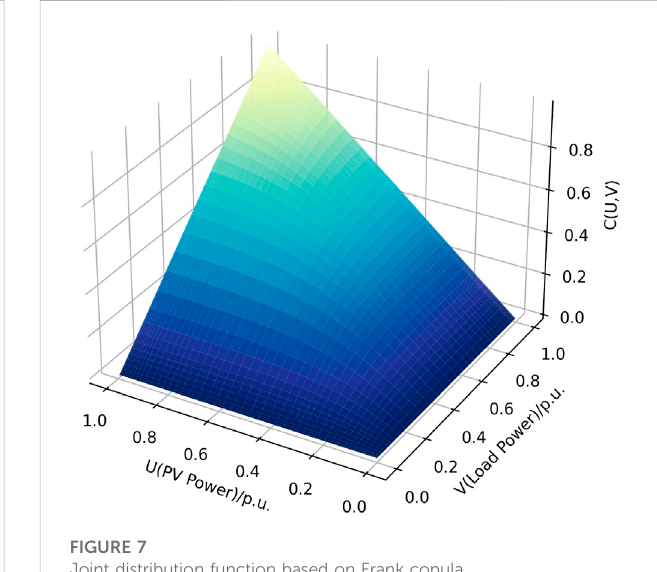
Joint distribution function based on Frank